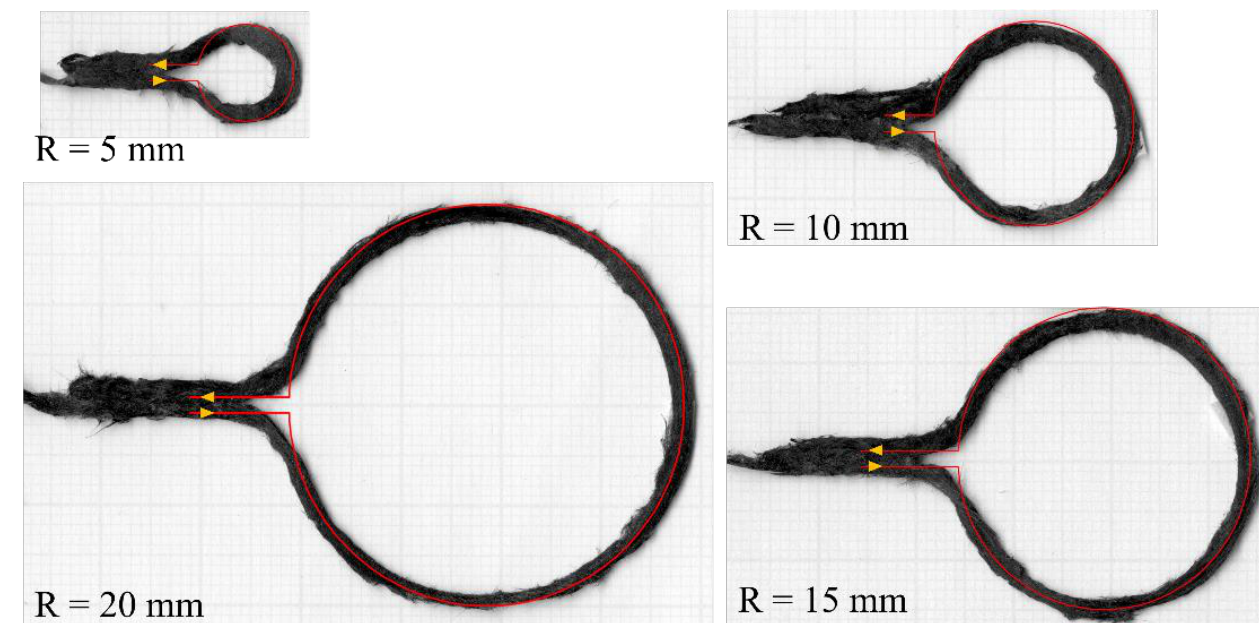
Figure 3. Deposited rasters at different radii from 5 to 20 mm presenting with the desired path (red line), same as the nozzle path, to show the dimension accuracy.